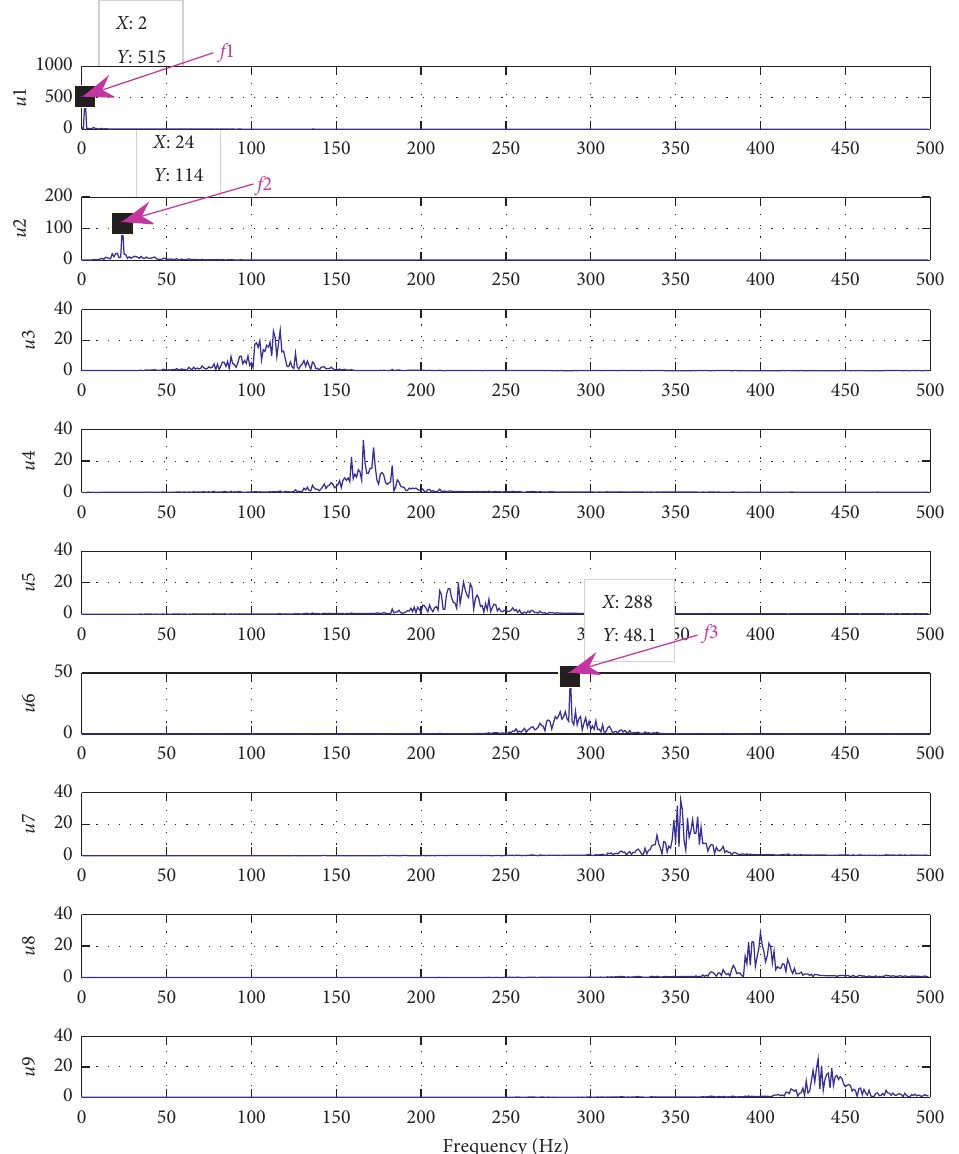
Figure 5: The spectrum of each mode decomposed by the proposed